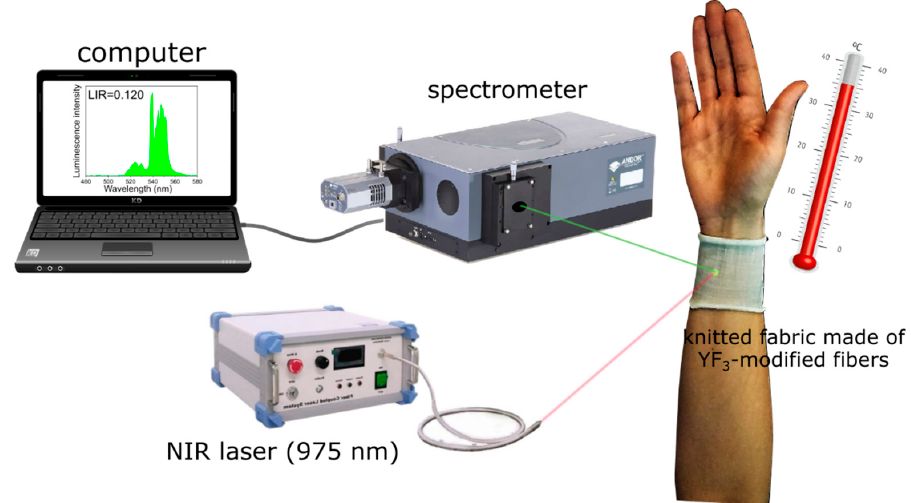
Figure 5 . Optical setup for temperature sensing based on a knitted fabric made of YF 3 -modified fibers. Table 2. Comparison of the cellulose-based temperature sensors reported in the literature with the YF 3 -modified cellulose fibers shown in this